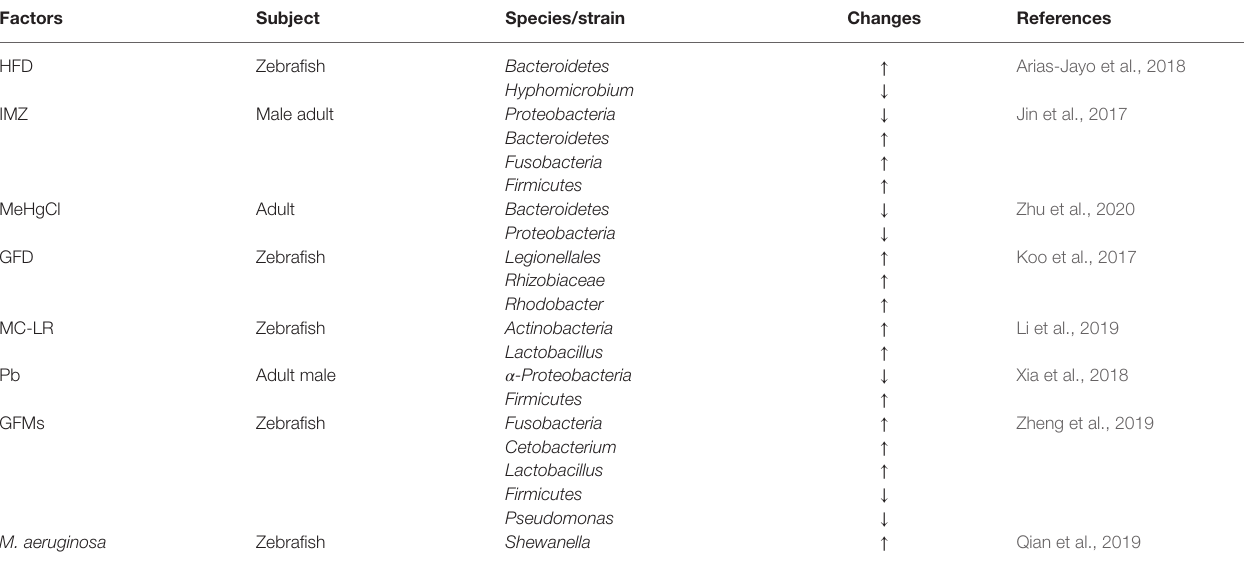
TABLE 3 | Various factors affect gut microbiota of zebrafish.